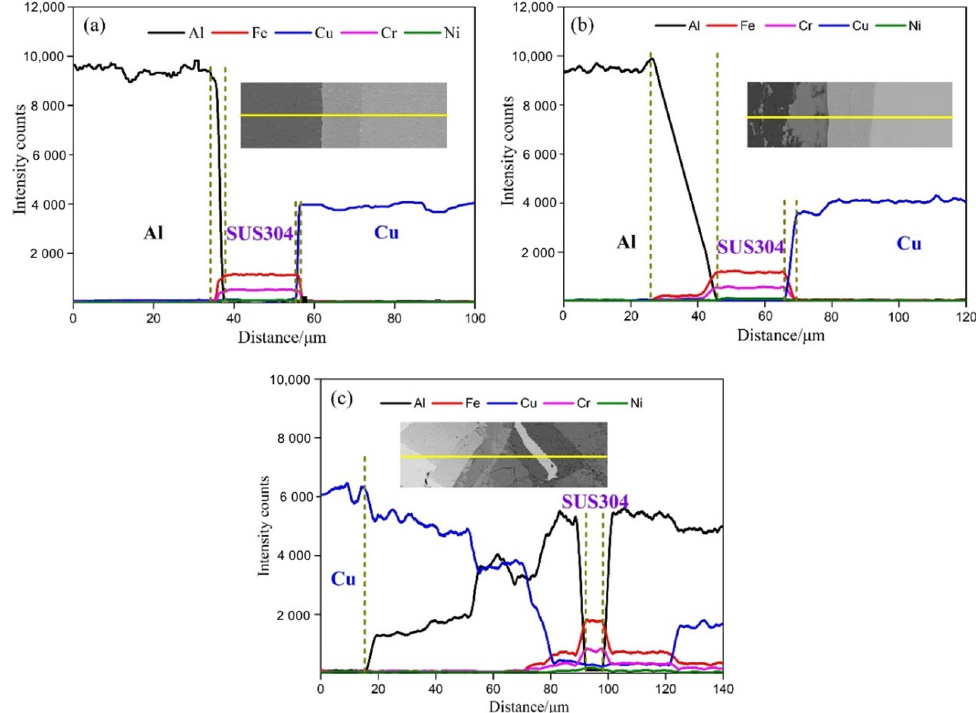
Figure 6. EDS line scan analysis across the Cu/SUS304/Al interface: ( a ) IFR-450, ( b ) IFR-550, ( c ) IFR-600.